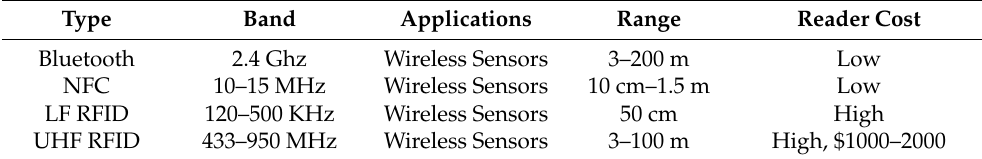
Table 1. Comparison of several wireless communication